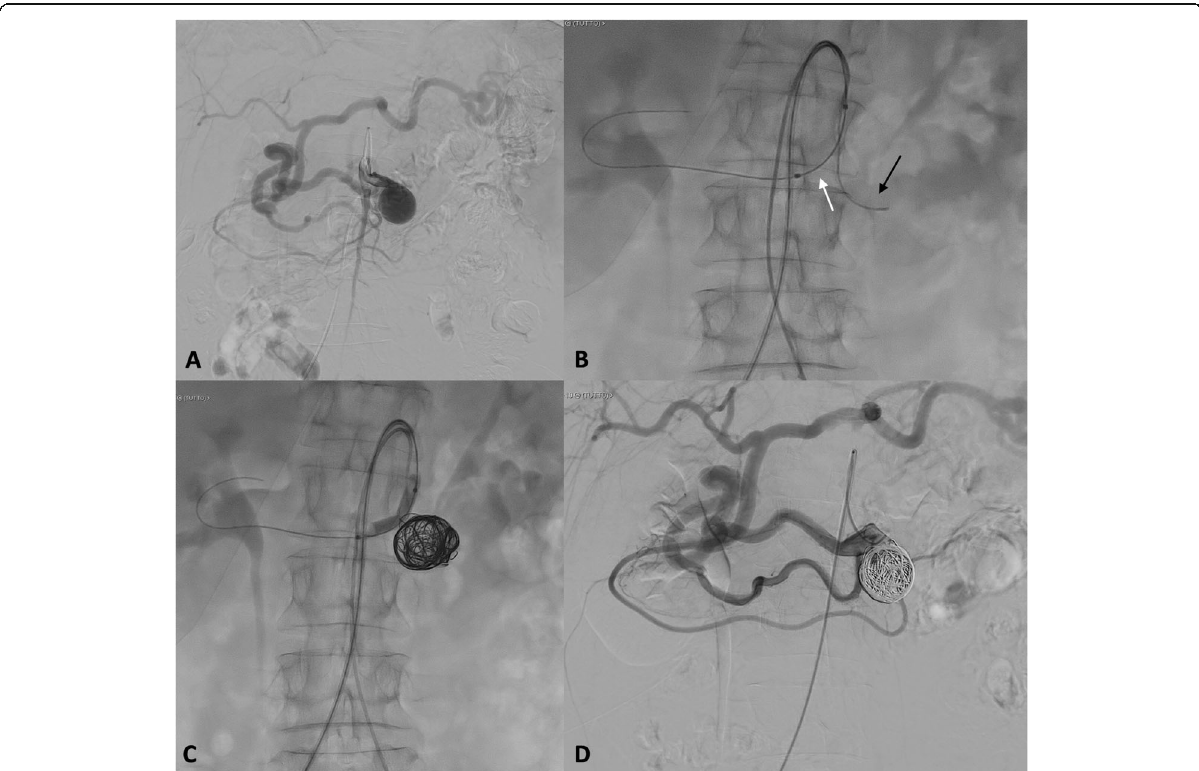
Fig. 2 preliminary angiogram confirmed the aneurysm and dilated inferior pancreatic duodenal artery with evidence of revascularization through this branch of the celiac trunk ( a ). A balloon was positioned across aneurysm neck and the aneurysmal sac was catheterized with a microcatheter ( b , black arrow). Then balloon was carefully inflated, and detachable non-fibered coils were delivered into the aneurysmal sac ( c ). The final diagnostic angiography showed completely exclusion of the sac from blood filling with preserved flow through PDA to the celiac